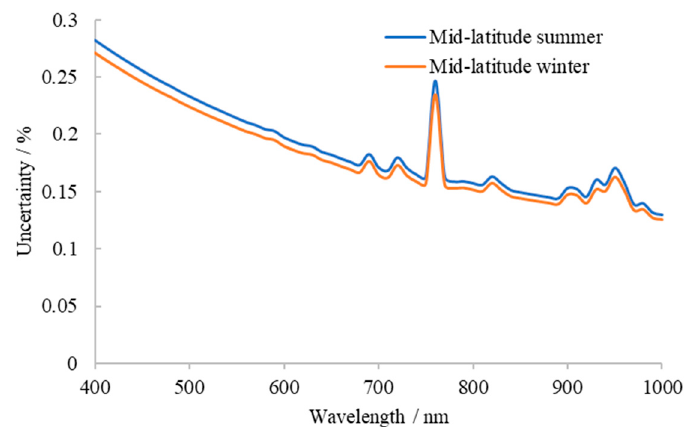
Figure 11. Uncertainty associated with downwelling irradiance (sun and sky) caused by a measurement uncertainty of 0.01 in the aerosol optical depth (AOD).